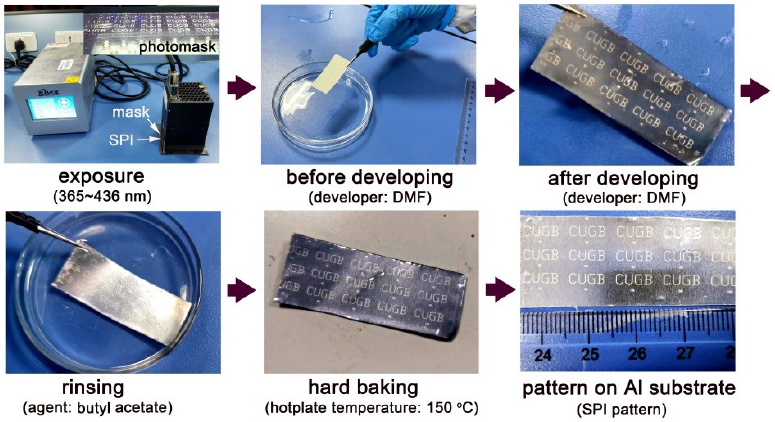
Figure 12. Photolithographic patterning process of SPI-4 NFM. (Insert: photomask).